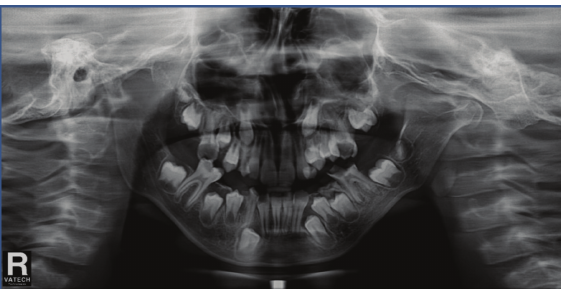
Figure 3: Panoramic radiograph of the patient before treatment.